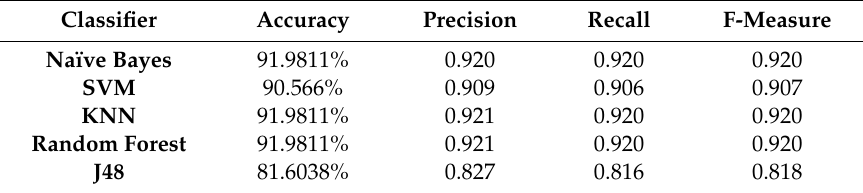
Table 2. Performance metrics for TX–RX of 15 cm features (632 features per case).